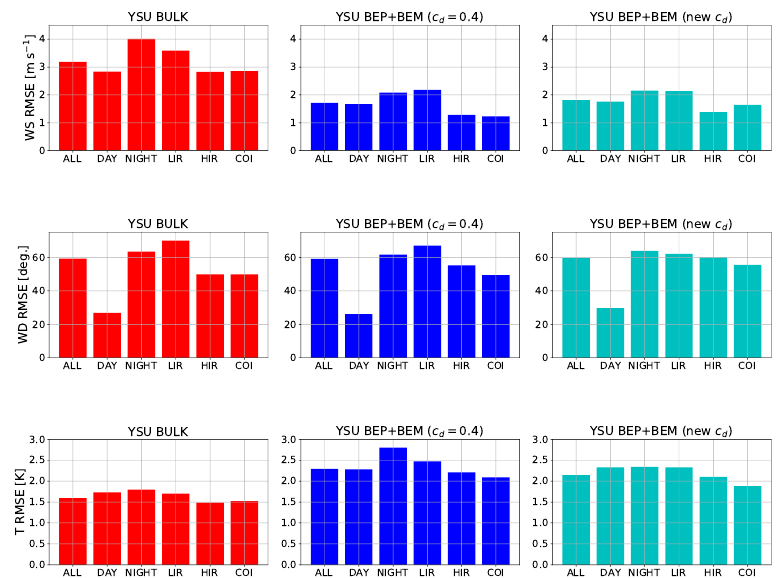
Figure 16. RMSEs in WS, WD, and T for each of the three simulations against the TCEQ measurements. RMSEs are stratified by day versus night, and for each urban class (LIR, HIR, and